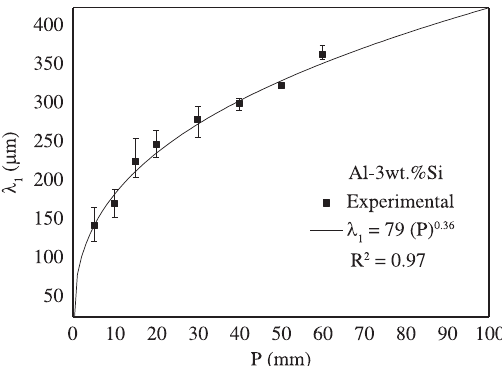
Figure 11. Primary dendrite arm spacing as a function of distance from chill for the Al- 3wt.%Si alloy.